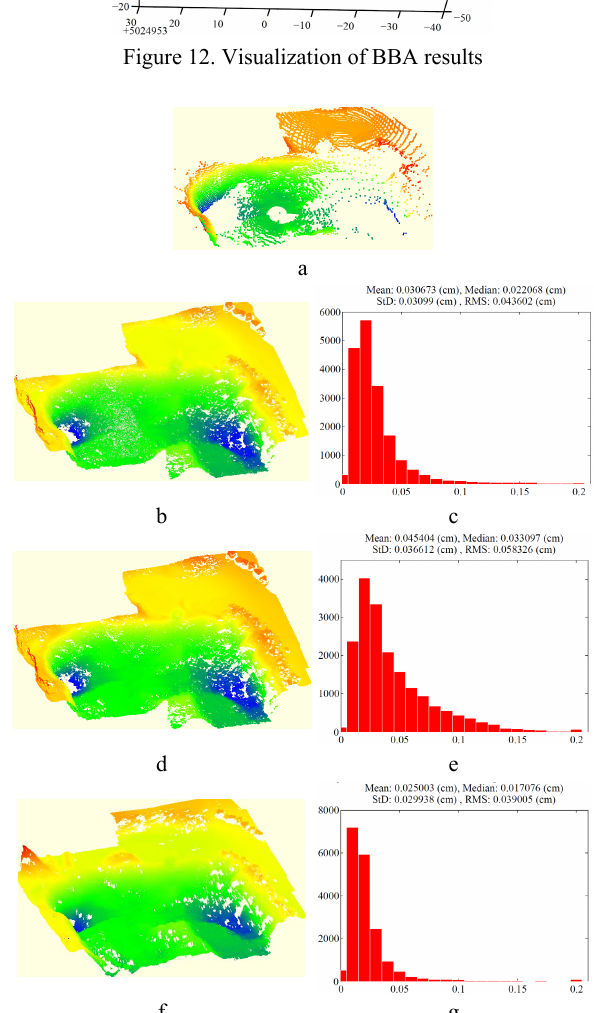
Figure 13. Visualization and accuracy analysis of the results. a) laser point cloud, b) dense point cloud from SURE using our EO and IO parameters, c) histogram of distances between point clouds (b) and (a), d) dense point cloud from SURE using Pix4D EO and IO parameters, e) histogram of distances between point clouds (d) and (a), f) dense point cloud from our algorithms, g) histogram of distances between point clouds (f) and